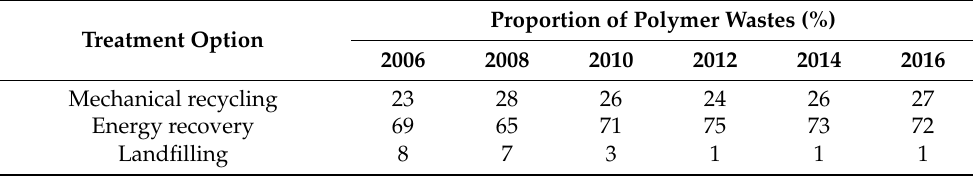
Table 3. Treatment options of plastic waste fractions in Austria from 2006 to 2016